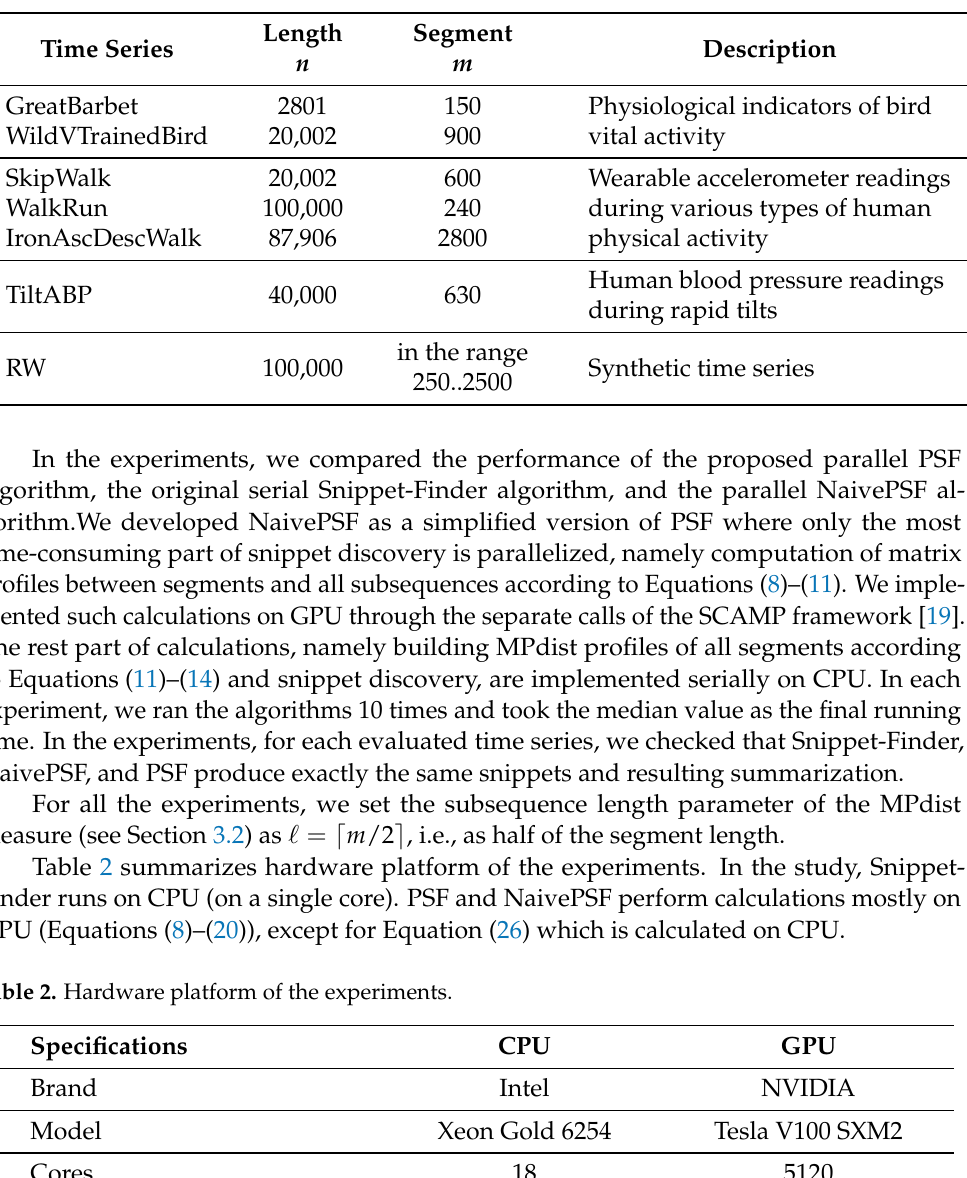
Table 1. Time series employed in the experiments.